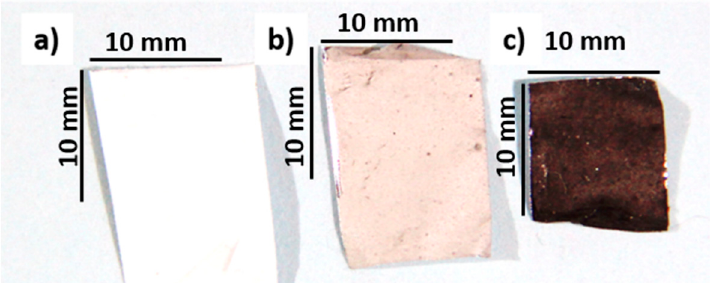
Polymers 2019 , 11 , x FOR PEER REVIEW Figure 1. Images of selected electrospun samples collected on aluminium foil: ( a ) Pure ethylene vinyl acetate (EVA), ( b ) EVA/1 wt % multiwall carbon nanotubes (MWCNTs), and ( c ) EVA/3 wt % MWCNTs.